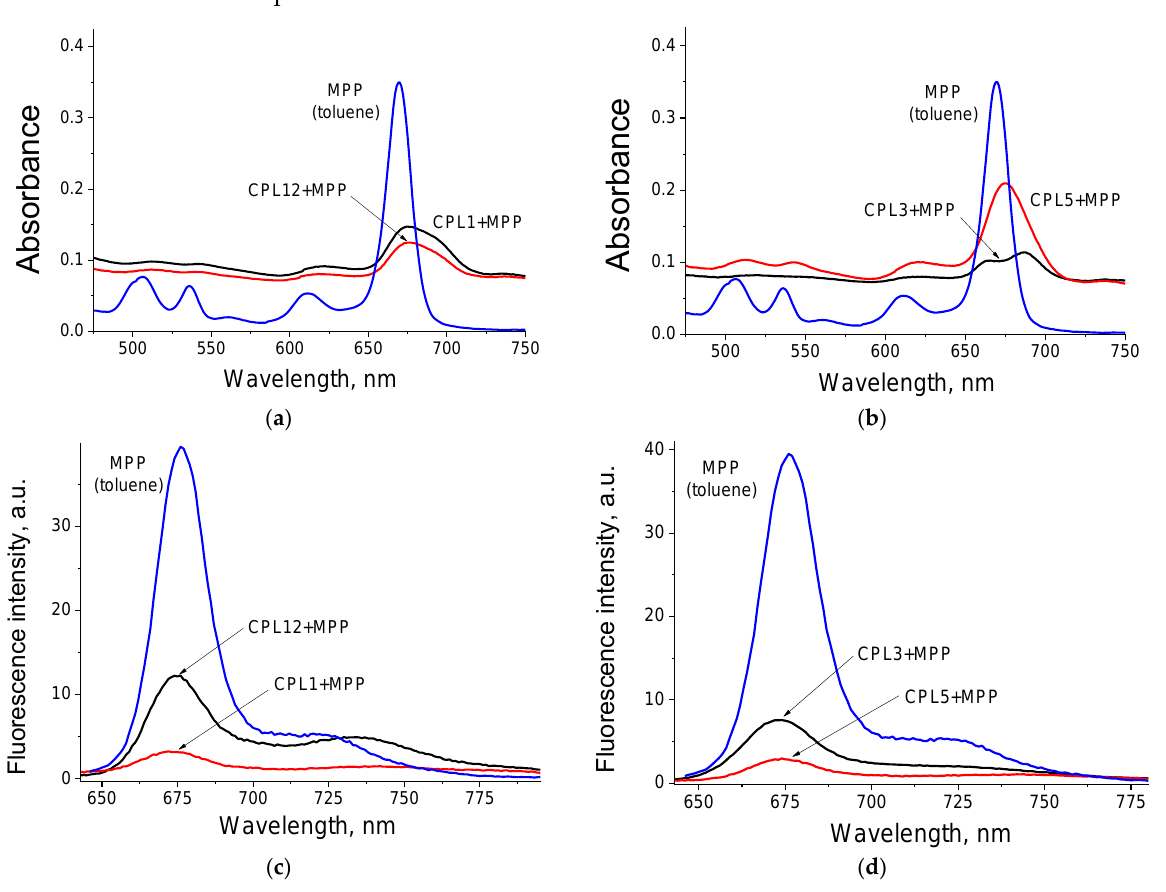
Figure 3. Absorption spectra ( a , b ) and fluorescence spectra ( c , d ) of nanoparticles in water solution and native MPP in toluene. For all fluorescence spectra λ ex = 420 nm. Concentration of MPP in NPs is 5 μM in water, native MPP in toluene—2 μM.